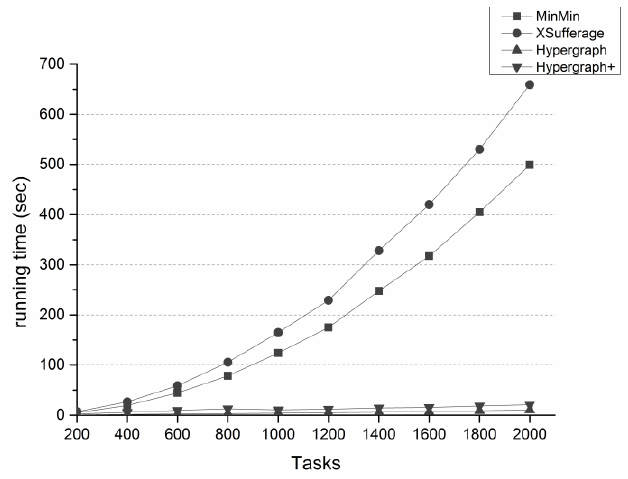
Figure 10. Performance evaluation with different numbers of tasks. ( a ) Makespan; ( b ) I/O reduction percentage.